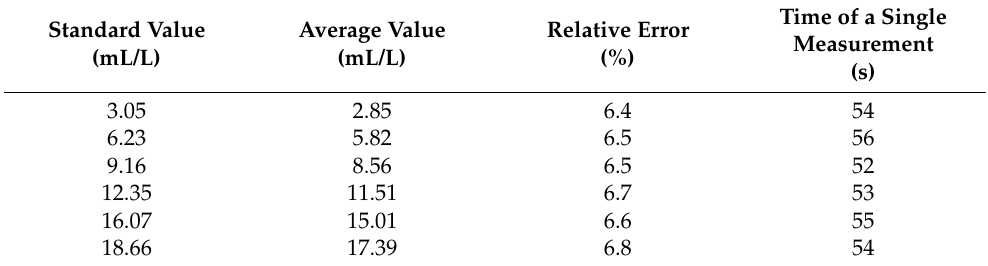
Table 1. Specific measurement